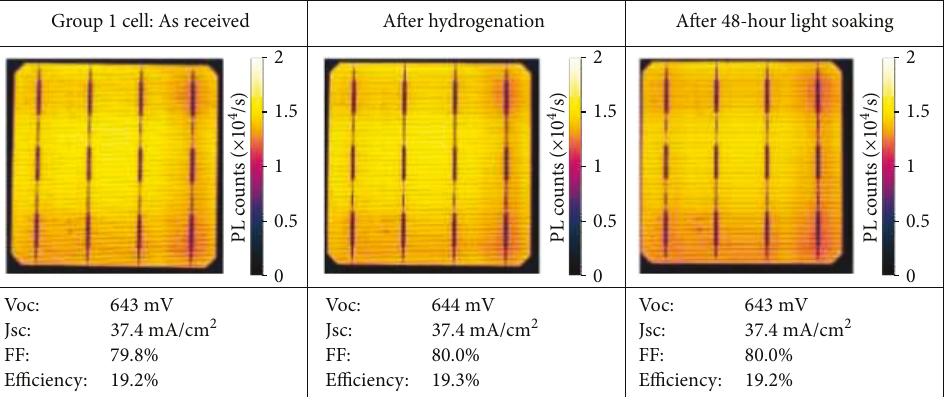
Figure 5: Performance of a group 1 normal cell after hydrogenation and then light soaking showing stable lifetimes after light